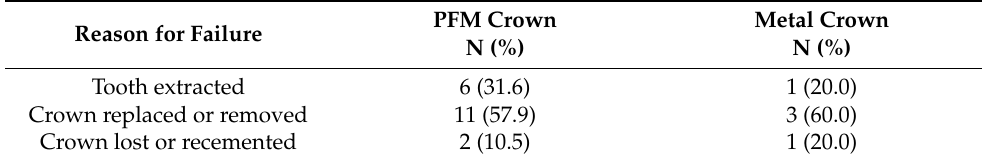
Table 4. Reasons for failure of PFM and metal crowns (N = 24).